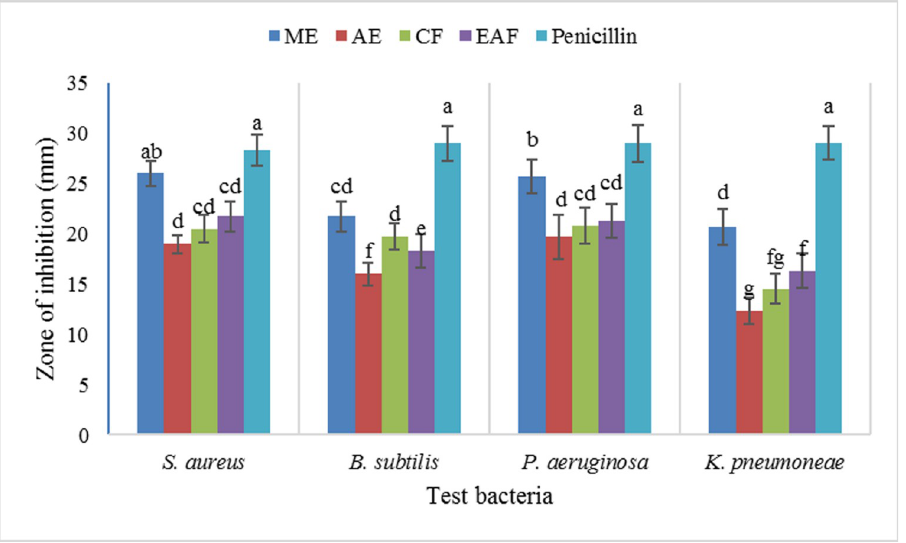
Fig 4. Zone of inhibition of J . mimosifolia methanol extract and different fractions against pathogenic bacterial strains. Data represent mean ± standard deviation (SD) of three biological replicates.